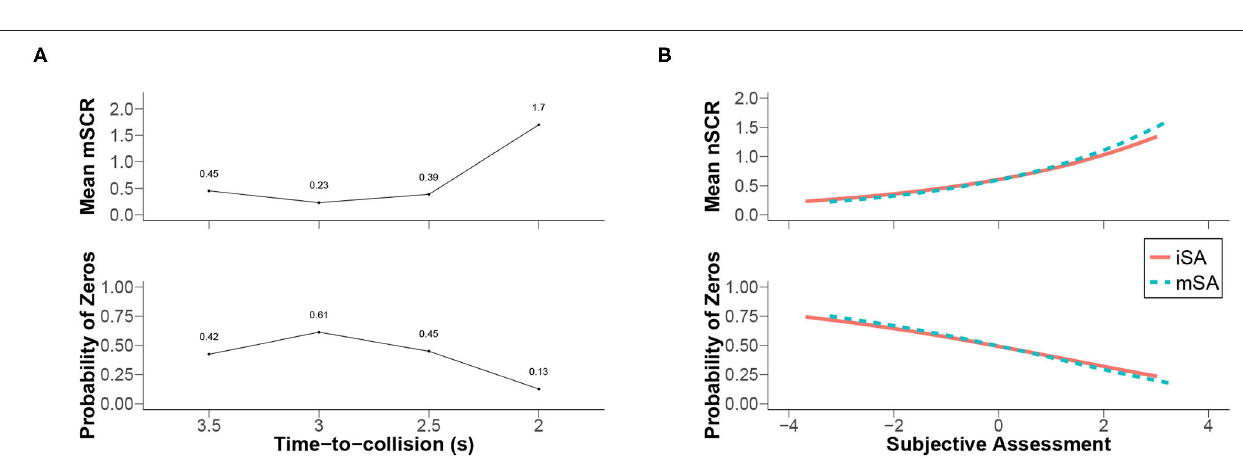
FIGURE 8 | Conditional means of SCR indicators according to the best Bayesian networks. (A) The means of the indicator mSCR in combination with the TTC values. (B) The means of the indicator nSCR as a function of the SA values. The probability of zeros was derived from the estimated parameters of each distribution (Tweedie). The relationships between the parameters of such distributions were, for instance, presented by Zhang (2013, eq.